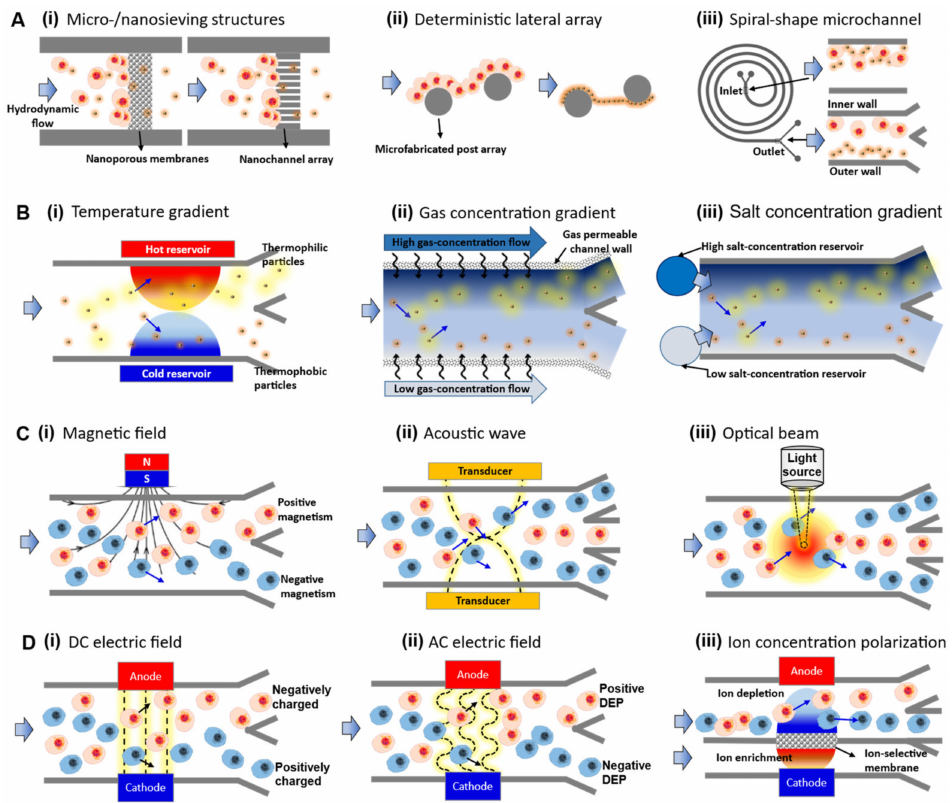
Figure 1. Schematic description of operational principles in microfluidic technologies for bioparticle separation. ( A ) Microfluidic passive separation group 1: hydrodynamic flow-based separation using ( i ) sieving micro-/nanostructures (filtration), ( ii ) deterministic lateral displacement arrays, and ( iii ) spiral-shape microchannels (inertial focusing); ( B ) Microflu- idic passive-force separation group 2: microenvironmental gradients, such as ( i ) temperature gradient (thermophoresis), ( ii ) dissolved gas concentration gradient (diffusiophoresis), or ( iii ) electrolyte concentration gradient (diffusiophoresis); ( C ) Microfluidic active-force separation group 1: non-contacting mechanical force, such as ( i ) magnetic field (magnetophore- sis), ( ii ) acoustic wave (acoustophoresis), and ( iii ) optical beam (optical tweezing); ( D ) Microfluidic active-force separation group 2: contacting electrical forces created by ( i ) DC electric field (electrophoresis), ( ii ) AC electric field (dielectrophoresis), or ( iii ) concentration polarization